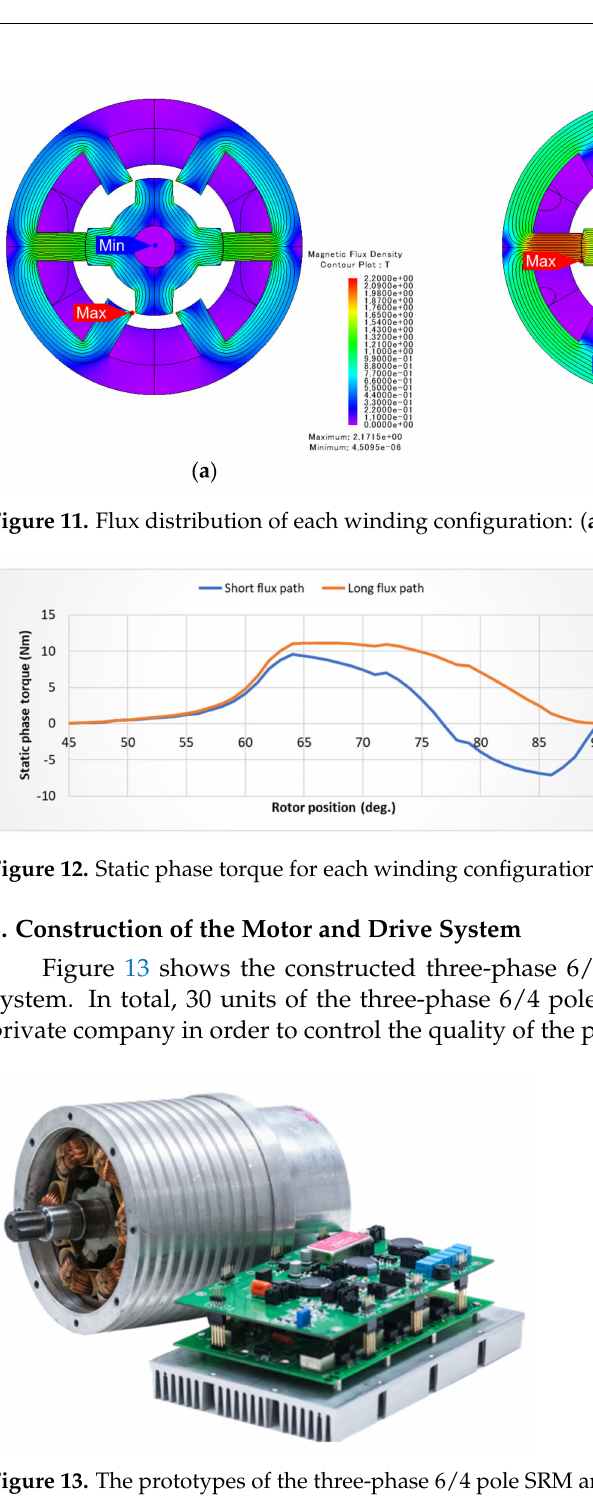
Figure 13. The prototypes of the three-phase 6/4 pole SRM and drive